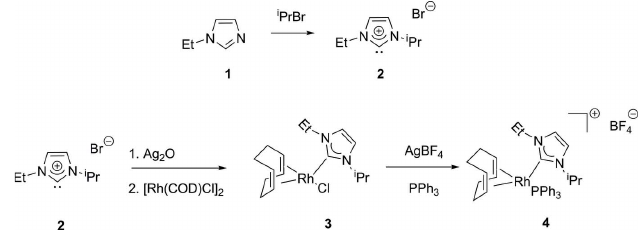
Figure 1 A view of the molecular entities in compound ( 4 ), showing the atom labeling. Displacement ellipsoids are drawn at the 50% probability